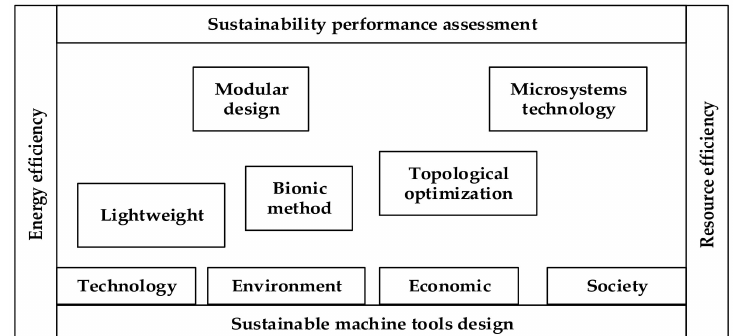
Figure 1. The key technologies of sustainable machine tools